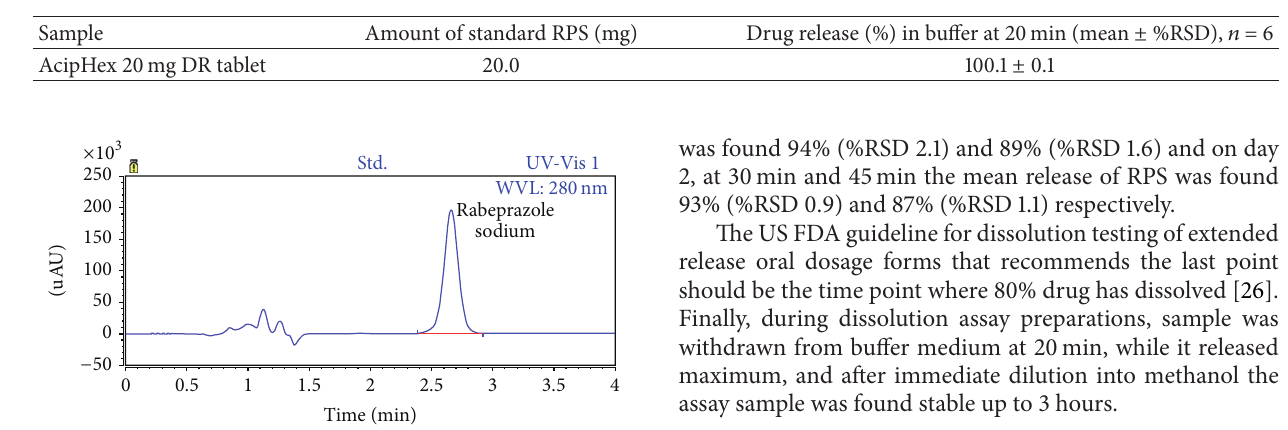
Table 7: Ruggedness of the method.